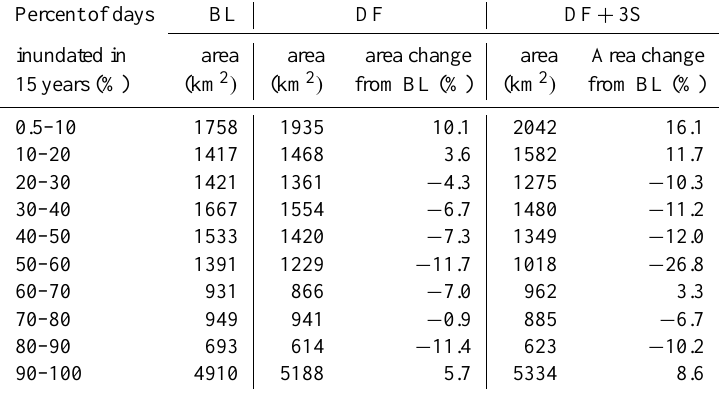
Table 5. Changes in spatial patterns of flooding in the Tonle Sap. Percent of